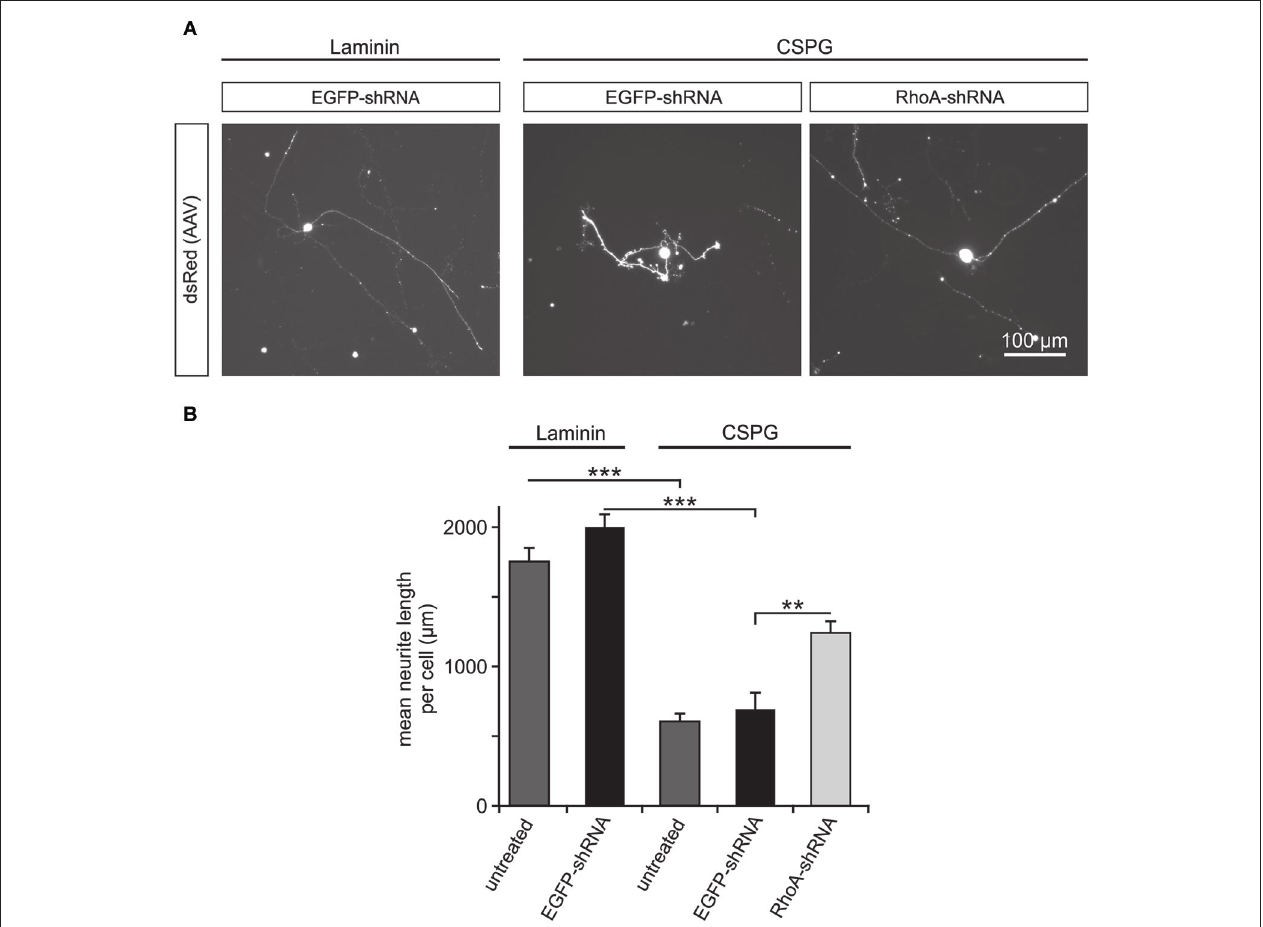
contrast, RGC transduced with AAV.RhoA-shRNA grow long neurites on CSPG. (B) Quantification of the mean neurite length per RGC transduced with the given AAV or untreated and plated either on laminin or CSPG ( n = 2 RGC-cultures; quantification of 20 fields of view per group and experiment; bars represent means ± SEM; ** p < 0.005, *** p < 0.001, according to one-way ANOVA followed by Dunnett’s post hoc